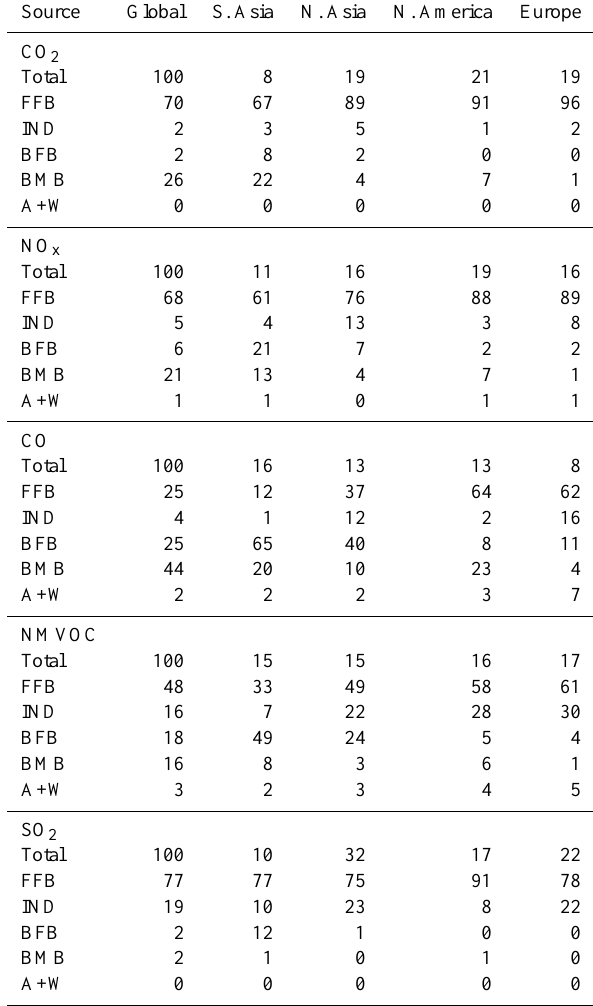
Table 3. Relative emissions of key trace gases. The source cat- egories and regions are the same as in Table 2. All values are in percent (%), rounded to the nearest integer (more accurate percent- ages can be derived from Table 2). The percentages in the top row for each gas are regional contributions relative to the global total for that gas (for all source processes combined). The percentages in each of the other rows are the contribution from that category to the total emissions of that gas in that particular region.